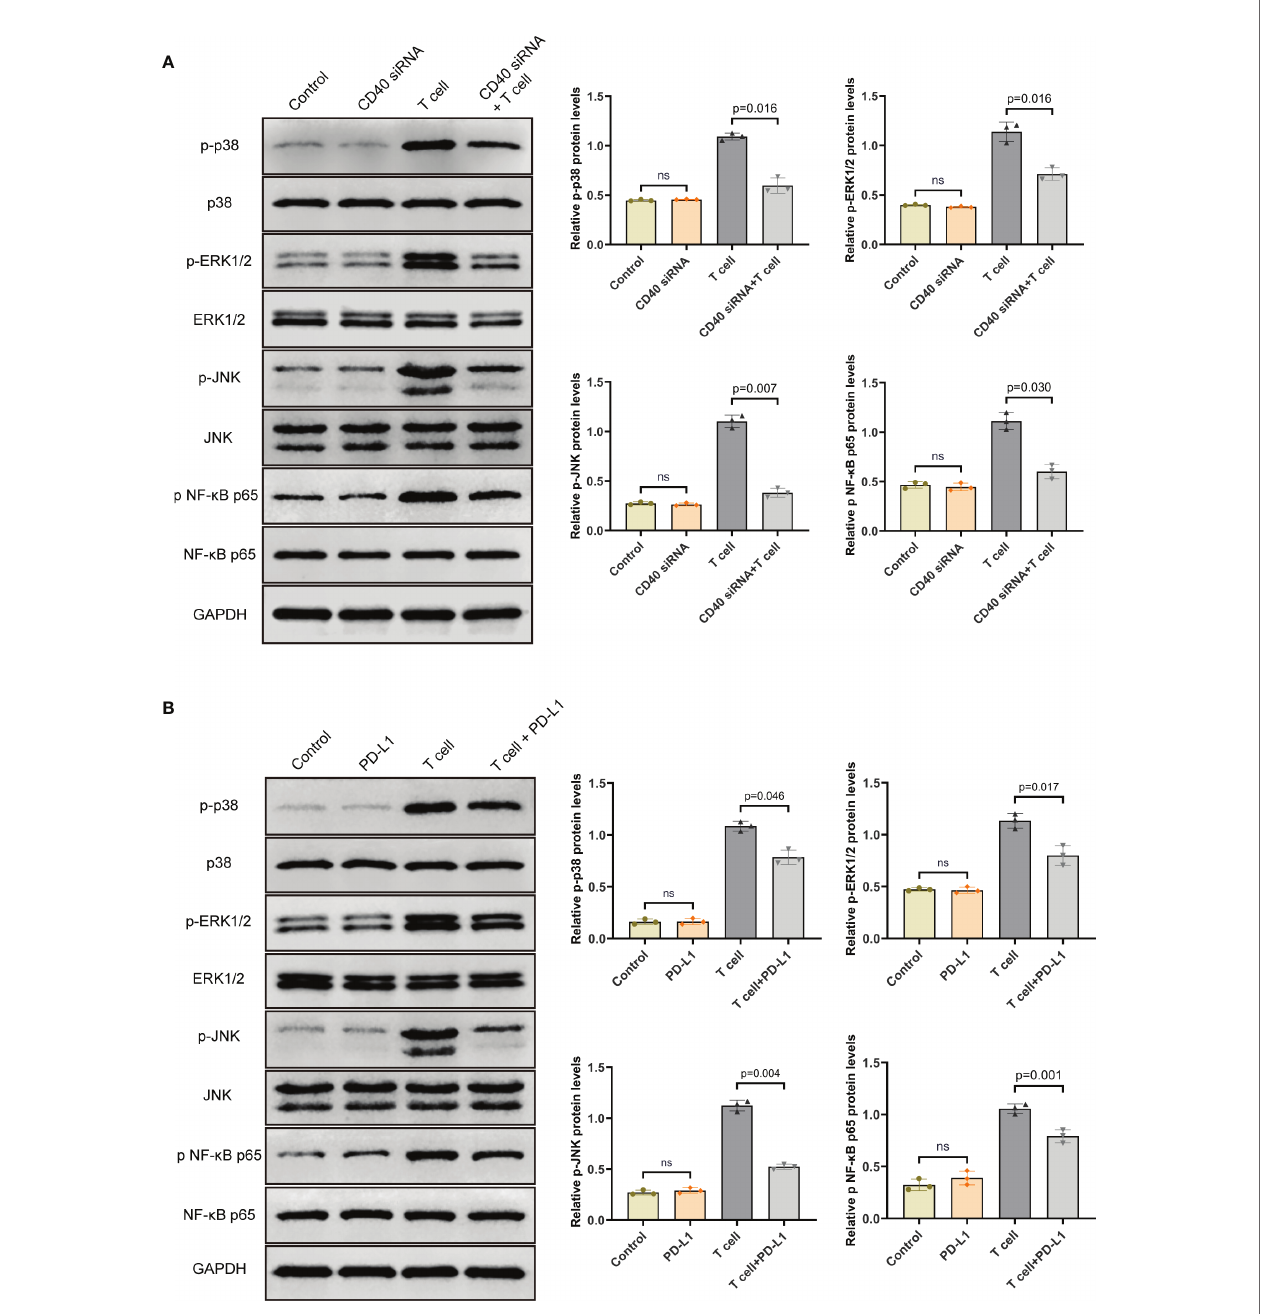
FIGURE 5 | PD-L1 down-regulated the phosphorylation levels of MAPK and NF- k B pathway proteins in TAO-OFs from the OF-T cell co-culture system via the CD40- CD40L pathway. (A) TAO-OFs and CD40-knockdown TAO-OFs were co-cultured with autologous T cells (OFs: T cells = 1: 10) for 24 hours or not, the total protein extracted from TAO-OF layers was subjected to western blot to detect the expression levels of p38, ERK1/2, JNK and NF- k B p65 in TAO-OFs. (B) TAO-OFs were treated with PBS, PD-L1 (10 ug/mL), autologous T cells (OFs: T cells = 1: 10), and T cells combined with PD-L1 for 24 hours, respectively. And the total protein extracted from TAO-OF layers was subjected to western blot to detect the expression levels of p38, ERK1/2, JNK and NF- k B p65 in TAO-OFs. Data are expressed as mean ± SD of triplicates. ns, no signi fi cance. Representative of three independent experiments using cells from a different